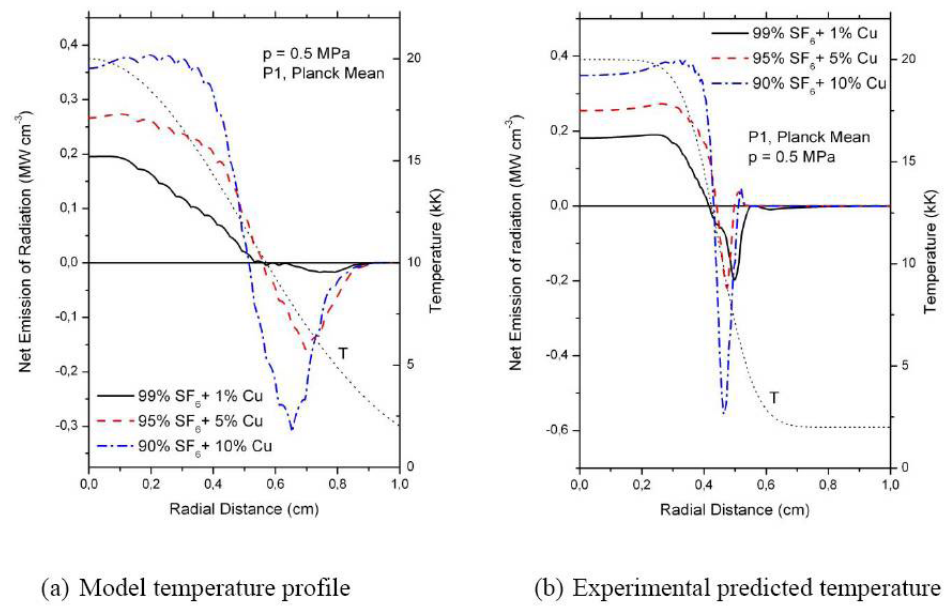
plasma with various admixtures of 6